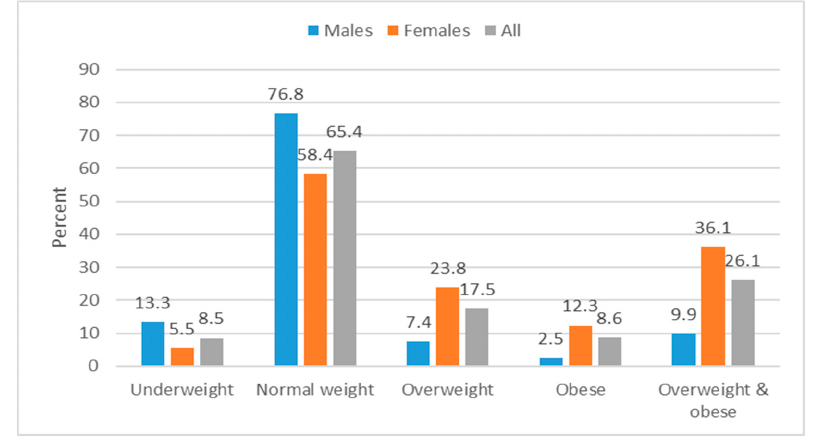
Figure 3. Anthropometric status of secondary school learners ( N = 1360) in Eastern Cape schools.